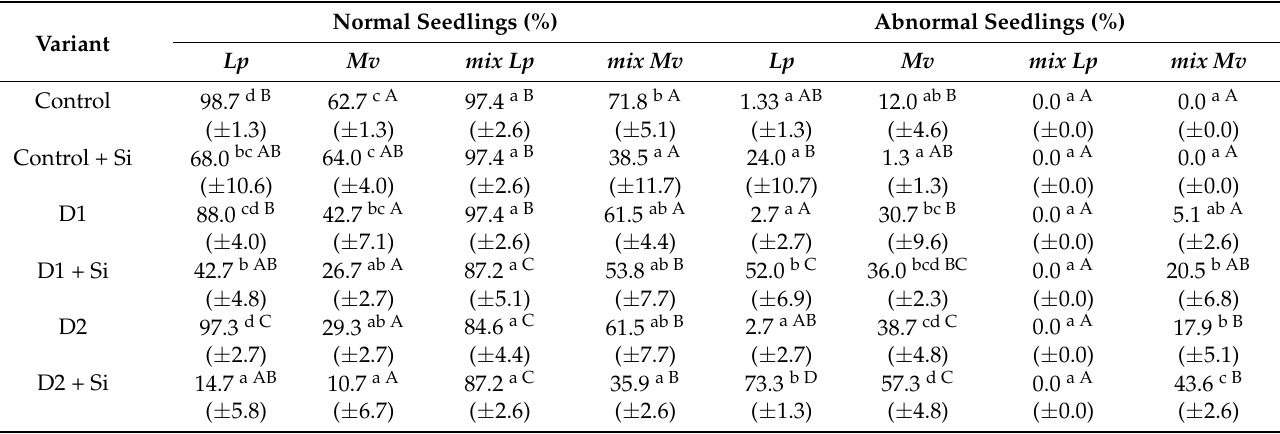
Table 2. Effects of different variants of drought conditions on normal and abnormal seedlings of Lolium perenne ( Lp ) and Medicago x varia ( Mv